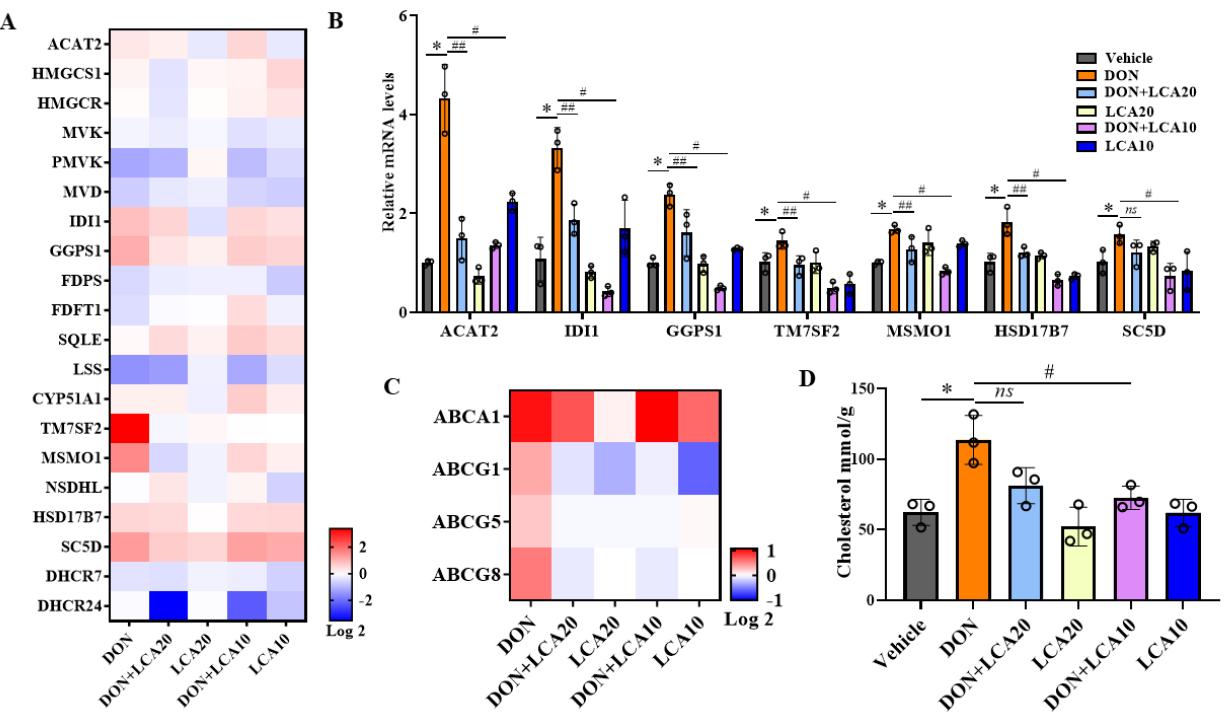
Figure 3. LCA modulates cellular cholesterol content homeostasis. ( A ) Heatmap analysis of gene expression (RNA ‐ seq) of key enzymes in cholesterol de novo synthesis (log2 transformed, normal ‐ ized to vehicle). ( B ) qRT ‐ PCR detects the gene expression of key enzymes in cholesterol synthesis, the relative expression levels were evaluated by qRT ‐ PCR. ( C ) Heatmap analysis of gene expression (RNA ‐ seq) in cholesterol efflux. ( D ) The level of total cholesterol in cells under different treatments was standardized by protein concentration. Results are mean ± SD. n = 3. * represents DON group vs. vehicle group p < 0.05. # represents DON + LCA10 group vs. DON group p < 0.05. ## represents DON + LCA20 group vs. DON group p < 0.05. ns represents no significant difference between the two groups.